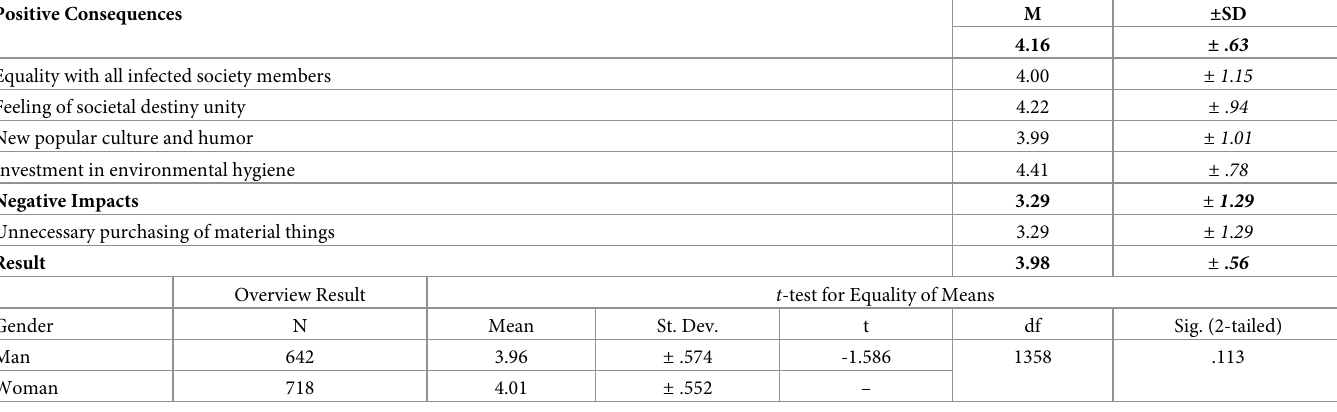
Table 6. Descriptive statistics for the impacts of COVID-19 on societal and environmental aspects of students’ lives. Positive